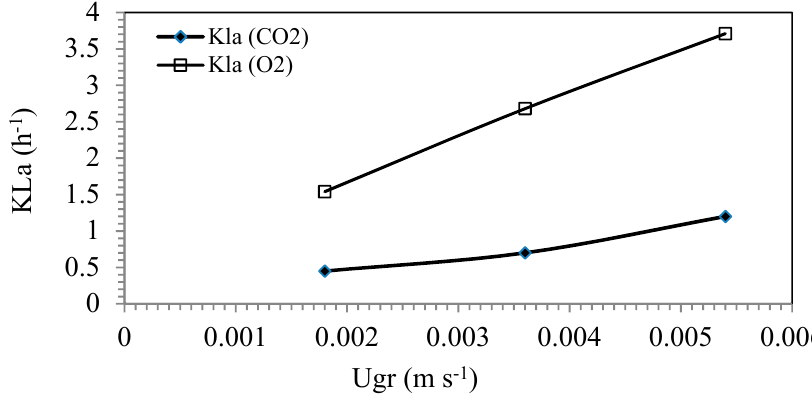
Figure 6. Effect of the superficial gas velocity Ugr on the volumetric mass transfer coefficient of CO 2 ( KLa CO2 ) calculated by the balance of CO 2 and KLa (O 2 ) using the dynamic method. Reyna-Velarde et al., 2010 [44], employing a flat panel Airlift reactor with Spirulina sp., obtained a KLa of 31.27 h − 1 . Contreras et al., 1998 [45], using a concentric tube Airlift reactor with a culture of Phaeodactylum tricornutum obtained a KLa of 28.8 h − 1 for a value of superficial gas velocity of 0.0018 m